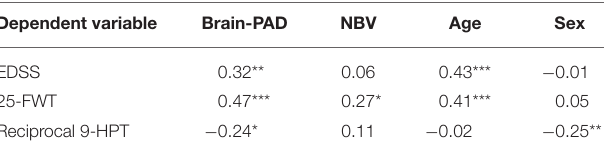
TABLE 2 | Standardized beta coefficients ( β ) from significant linear regression models of clinical and blood measures. Dependent variable Brain-PAD